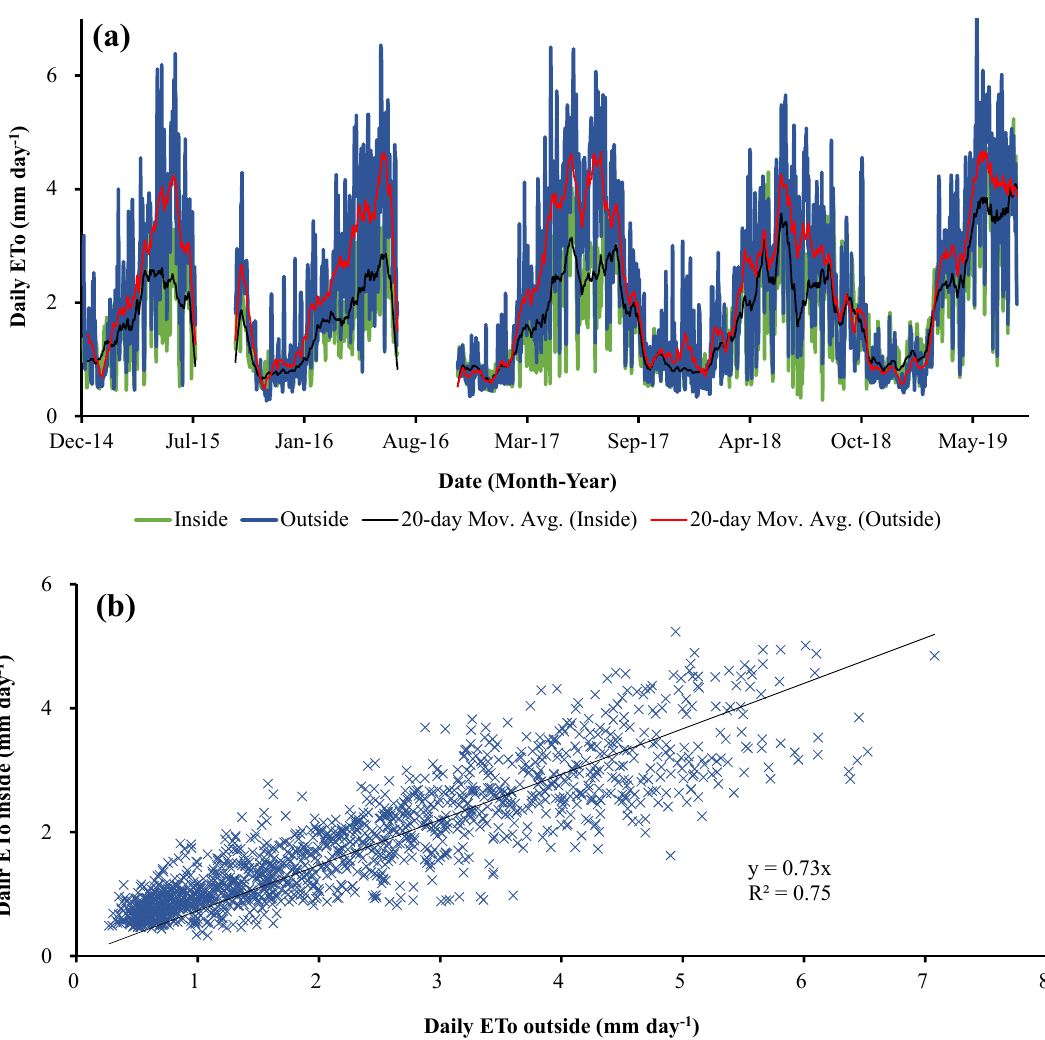
Figure 11. Daily reference crop evapotranspiration (ET o ) inside and that outside of the sunken solar greenhouse during the seven seasons ( a ) and the linear relationships between inside and outside values ( b ). The black and red thin solid lines on ( a ) represent the 20-day moving averages of ET o inside and outside, respectively.